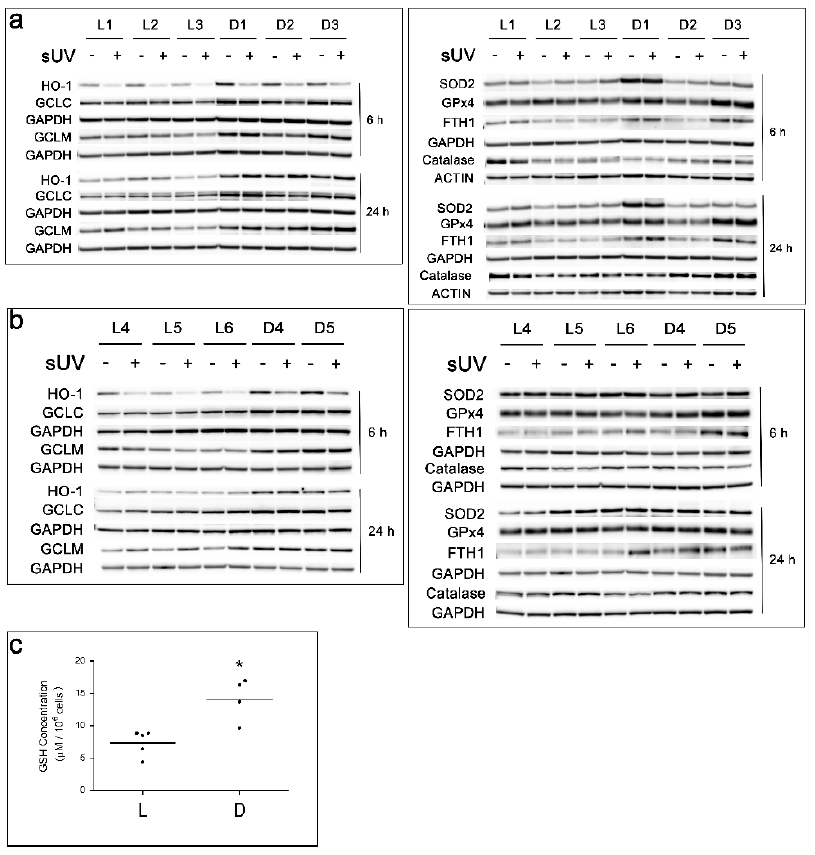
Figure 4. Comparison of the basal and solar UV-induced levels of the antioxidant enzymes HO-1, GCLC, GCLM, SOD2, GPx4, FTH1, and catalase in 6 L and 5 D melanocyte cultures, as determined 6 and 24 h post-irradiation with 7 J/cm 2 solar UV by Western blot analysis of the total proteins and quantitation of the basal levels of reduced GSH in 5 L and 5 D cultures. ( a , b ) The results of 2 independent experiments. GAPDH and actin were used as the loading controls. ( c ) Comparison of basal-reduced GSH levels in L1, L2, L4, L5, and L6 versus D2, D3, D4, and D5. * = Mean GSH content in D cultures is statistically different from that in L cultures ( p < 0.01).